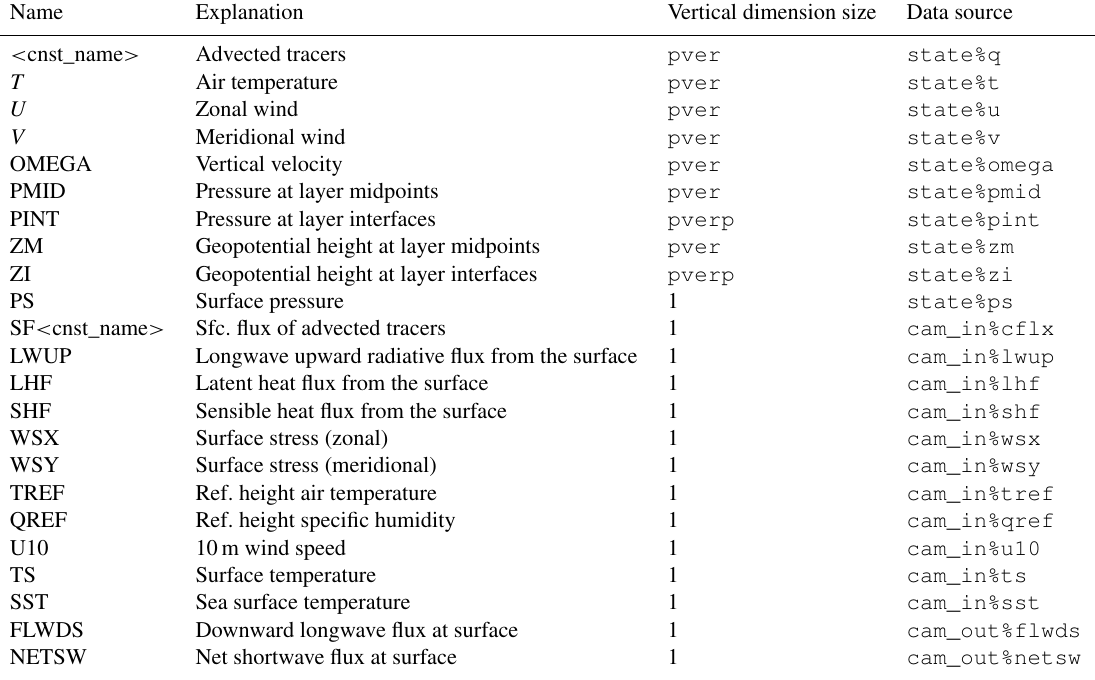
Table A1. Candidate condition metrics and QoIs that are directly copied from EAM’s derived-type data structures. “ < cnst_name > ” refers to tracer names in EAM. “SF < cnst_name > ” refers to variable names of tracer surface fluxes in EAM. pver and pverp are EAM’s variable names for the number of vertical layers and vertical interfaces, respectively. In the standard EAMv1, pver is 72 and pverp is 73. The rightmost column explains the Fortran derived-type variables and their components from which a metric or QoI’s values are obtained. More candidate metrics and QoIs can be added following the example shown by the first code snippet in Sect. 4.1.2.